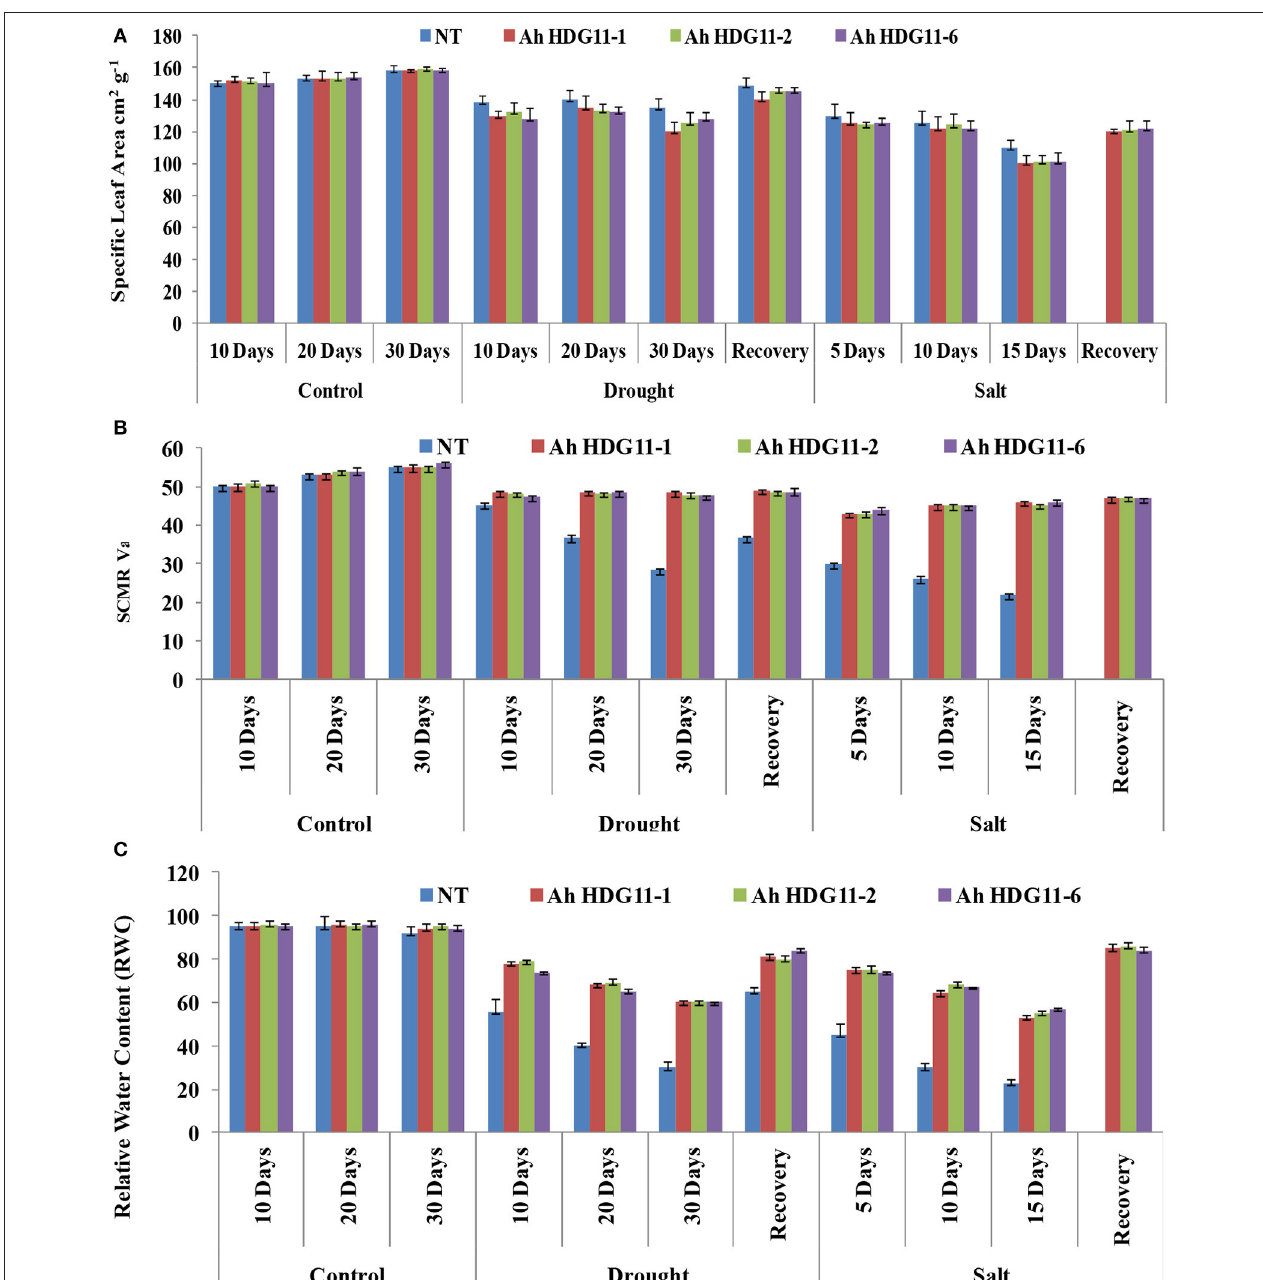
FIGURE 7 | Physiological analysis of transgenic lines AhHDG11-1, AhHDG11-2, AhHDG11-6 along with the Non-transgenic (NT) plants. (A) Specific Leaf Area (SLA) (B) Chlorophyll content (SCMR) (C) Relative Water Content (RWC).